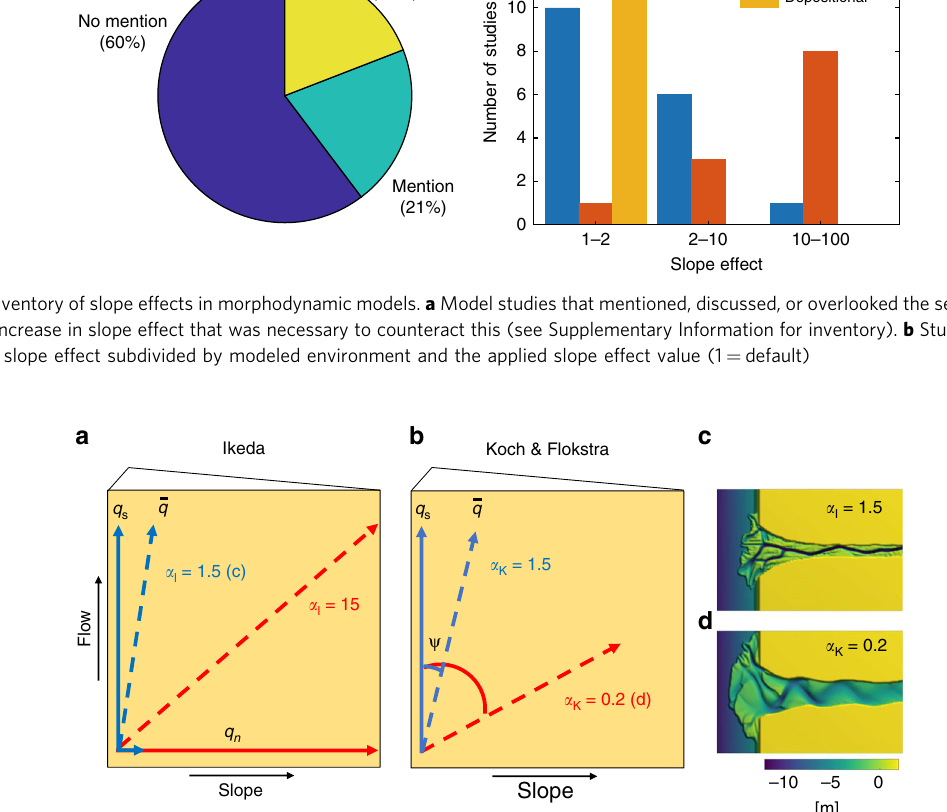
Fig. 2 Schematic drawing of the two main slope parameterizations. The parameterizations for sediment de fl ection by Ikeda 27 ( α ( α ) drawn on a transverse bed slope. Both methods are drawn on a top view of a bed sloping toward the right. Blue solid arrows show sediment transport K in streamwise direction ( q ) and transverse direction ( q n , only for Ikeda), and dashed blue arrows show the resulting transport vectors ( q ) with default s values for the slope effect. Red arrows represent transport vectors when the slope effect is increased to typical values used in current model studies. a The method of Ikeda increases the transverse sediment vector as a function of slope and α b The method of Koch and Flokstra rotates the streamwise transport vector over an angle ( ψ ) as a function of slope and α See Supplementary Note 1 for detailed calculation method and how to translate α = 0.2) slope effect (see Supplementary Fig. 6 for more high ( α K